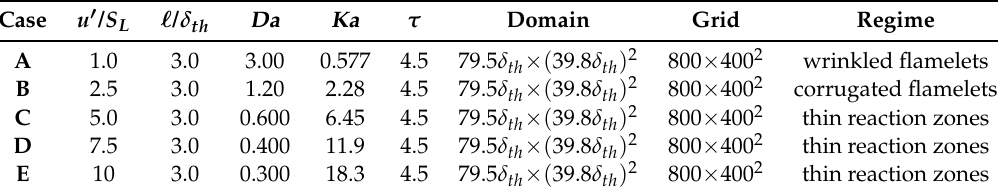
Table 1. The properties of the DNS database considered in this